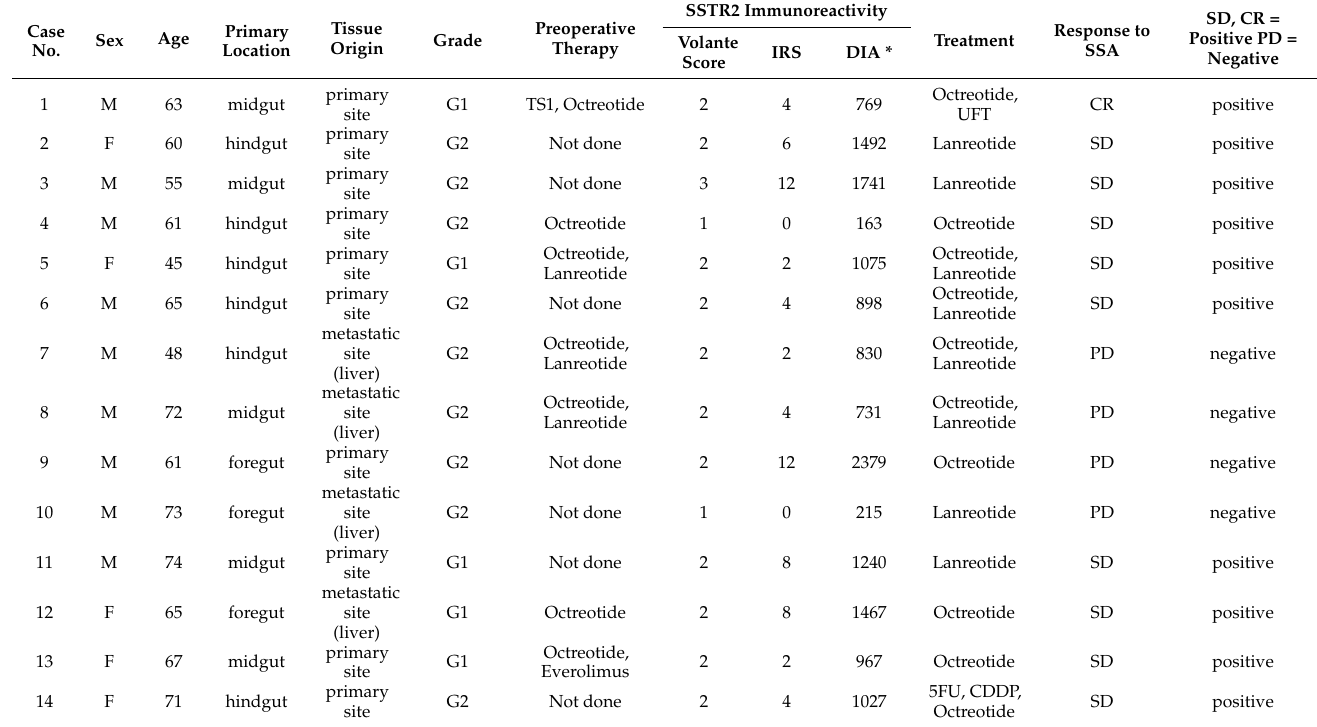
Table 3. Summary of the clinicopathological characteristics of Group 3